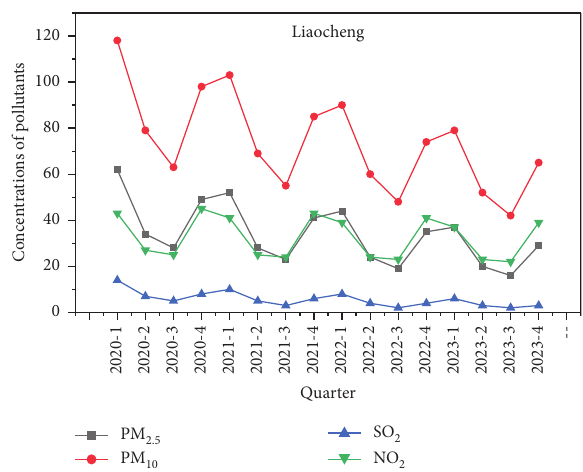
Figure 6: The predicted concentrations of four pollutants in